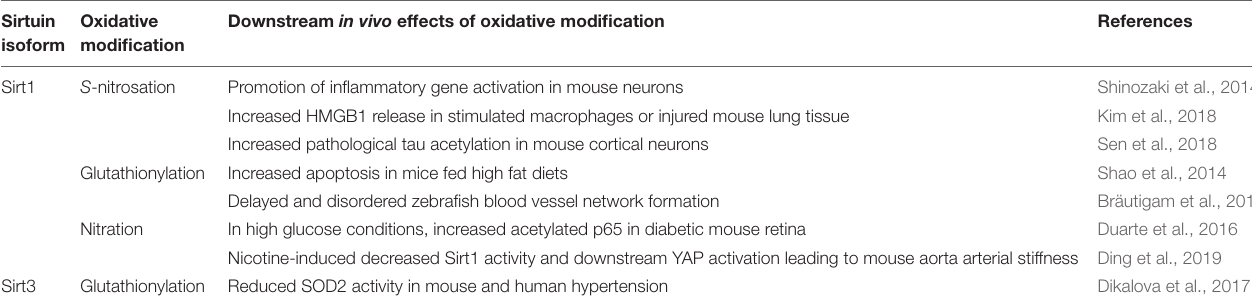
TABLE 4 | Known downstream in vivo effects of oxidative modifications of Sirt1 and Sirt3 in animal model